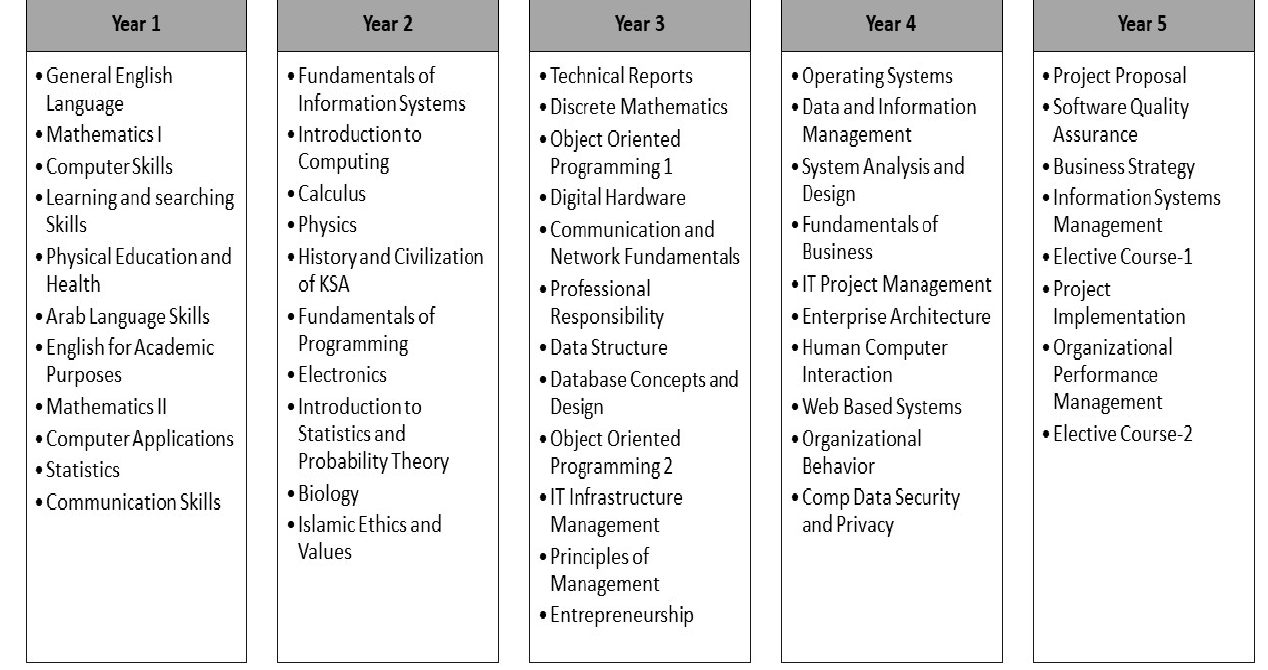
Figure 1. Curriculum of Bachelor of Science in Computer Information Systems Program.